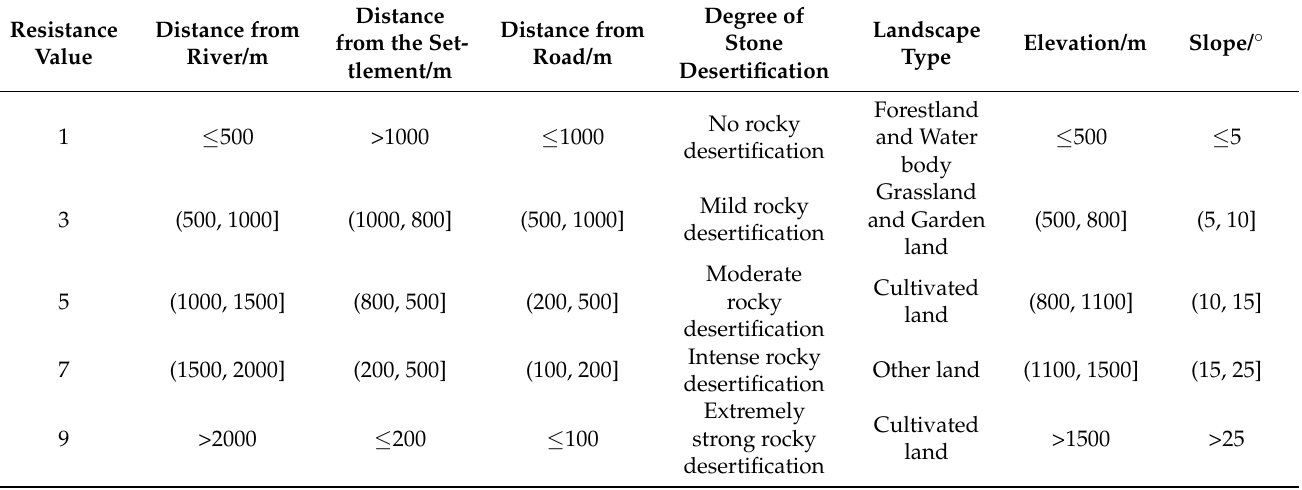
Table 3. Ecological resistance surface evaluation